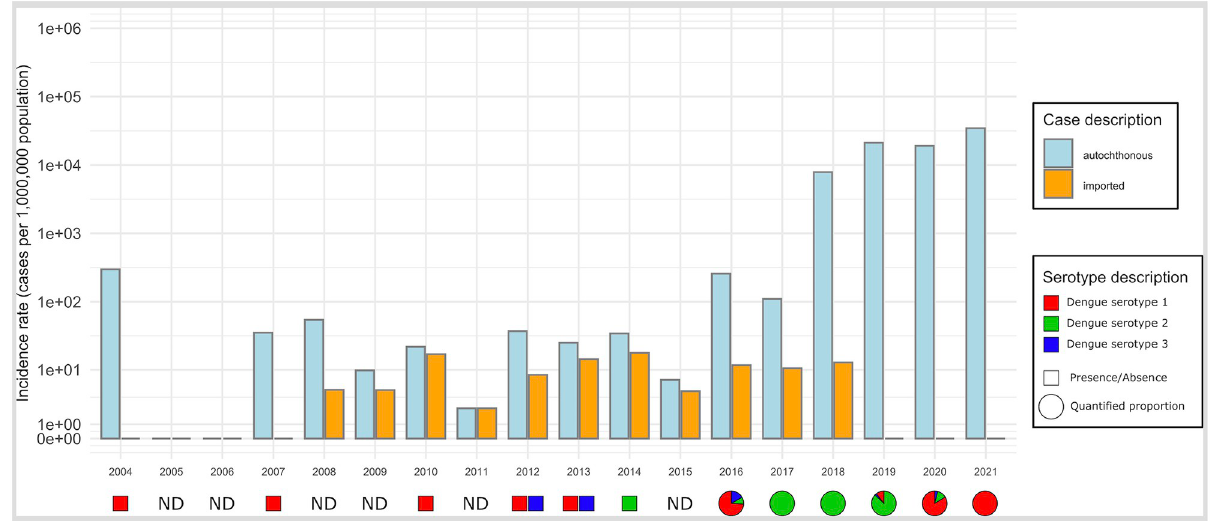
Fig 2. Incidence of autochthonous dengue cases per million population in Reunion from 2004 to 2021. Incidence is expressed in cases per million population for visualization purposes. The distribution of DENV serotypes are given for autochthonous cases based on the number of samples serotyped in 2016 (93 out of 221), 2017 (94 out of 94), 2018 (950 out of 6,770), 2019 (883 out of 18,217), 2020 (836 out of 16,414), and 2021 (978 out of 29,577). DENV, dengue virus; ND, unavailable data.